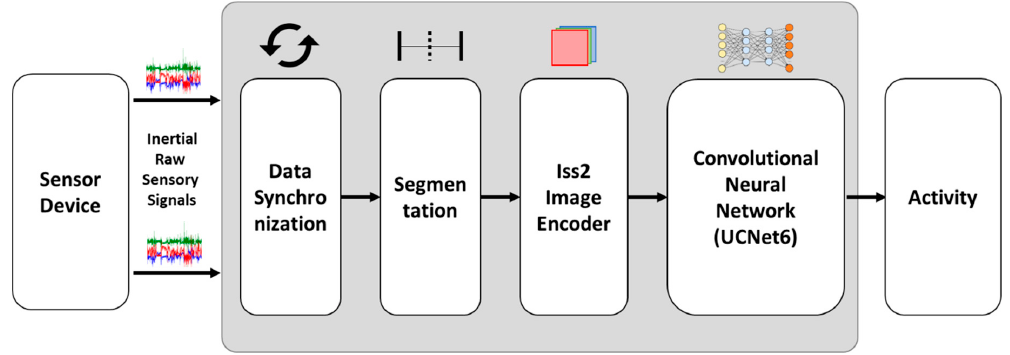
Figure 1 . The workflow of our proposed method for human activity recognition; the main Figure 1. The workflow of our proposed method for human activity recognition; the main contributions contributions are the data encoder and CNN model. are the data encoder and CNN